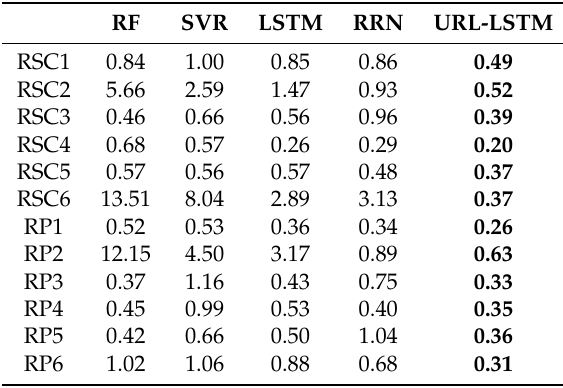
Table 2. The MRE